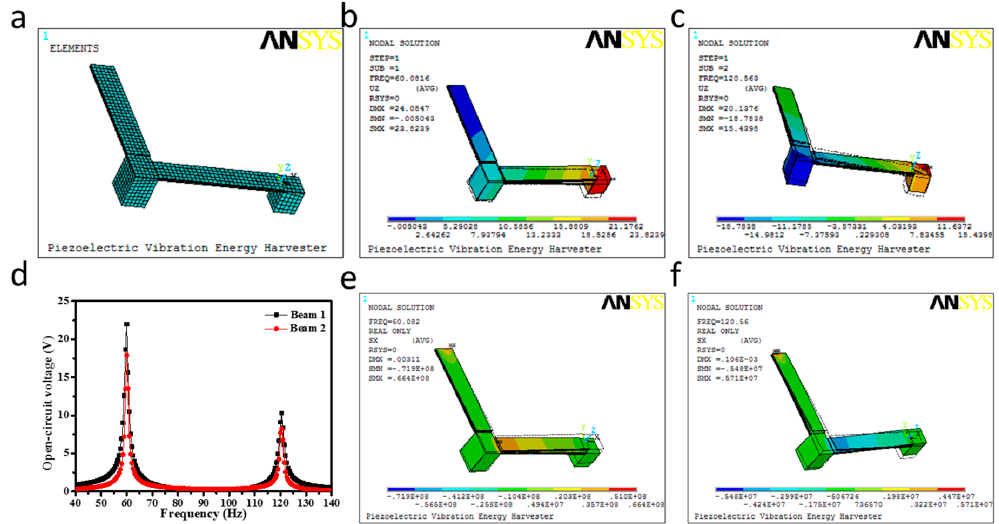
Figure 4. ( a ) Finite element models of the wideband piezoelectric vibration energy harvester in ANSYS; ( b , c ) The first two vibration modal analysis of the wideband piezoelectric vibration energy harvester; ( d ) The dynamic frequency vs. the open-circuit voltage; ( e , f ) The stress nephograms along the length of the beams of the wideband piezoelectric vibration energy harvester.